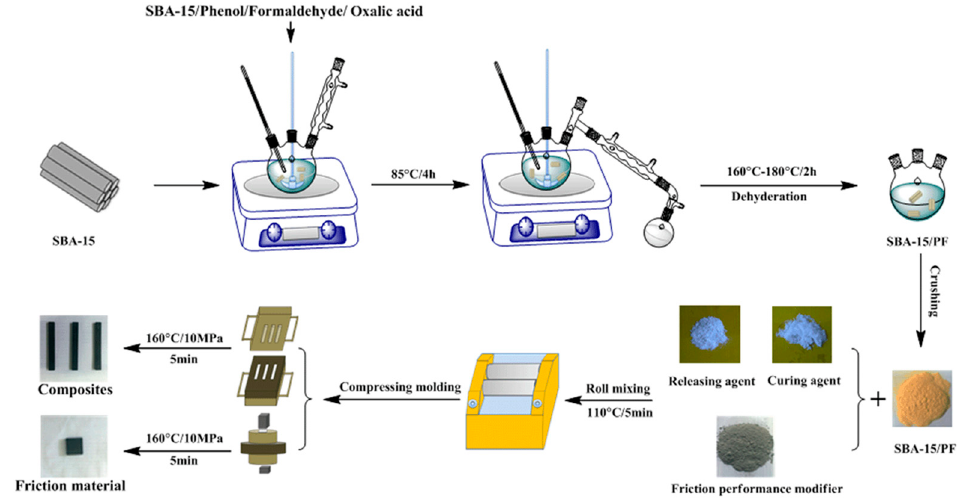
Figure 1. Schematic illustration of fabrication process of the SBA-15/PF hybrid and SBA-15/PF nano- composites.